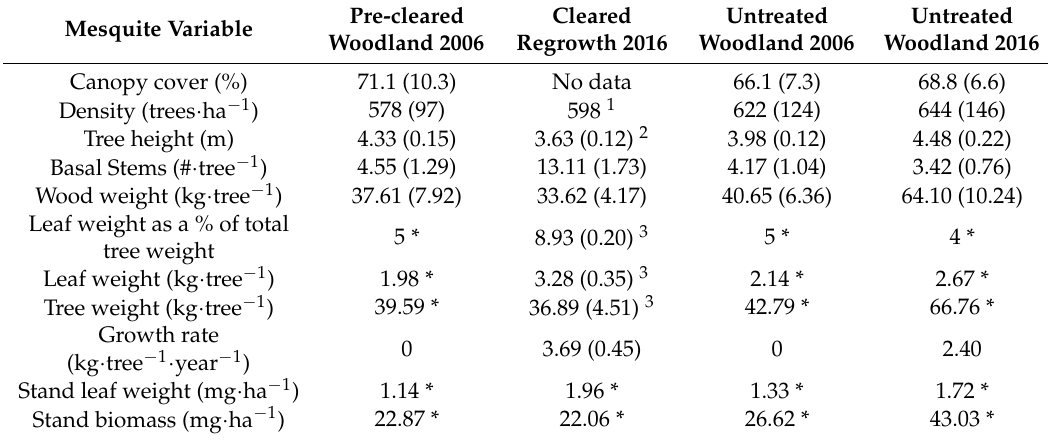
Table 1. Mesquite stand and individual tree data in the cleared treatment prior to clearing (2006) and at 10 years post-clearing (2016), and the untreated woodland in 2006 and 2016. Asterisk indicates a projected value, based on leaf weight being either 5% (2006), or 4% (2016) of total tree weight [17]. Means are followed by standard error in parentheses. No statistics were provided for projected values.